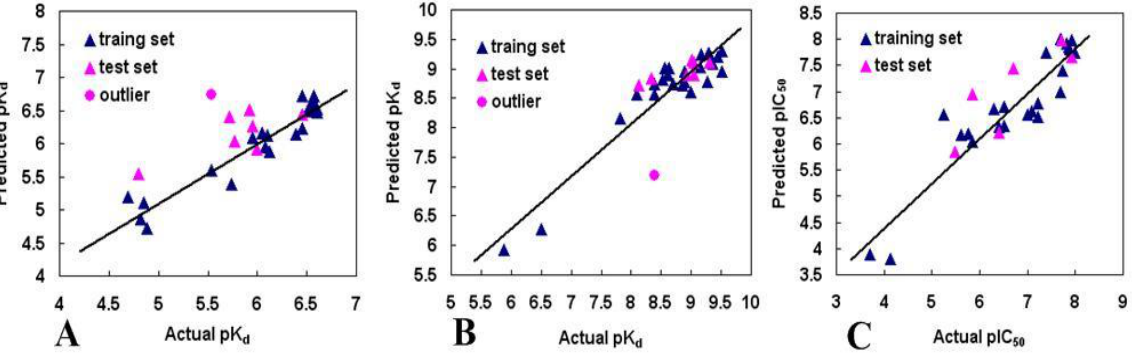
versus the experimental p IC values for the models. 50 50